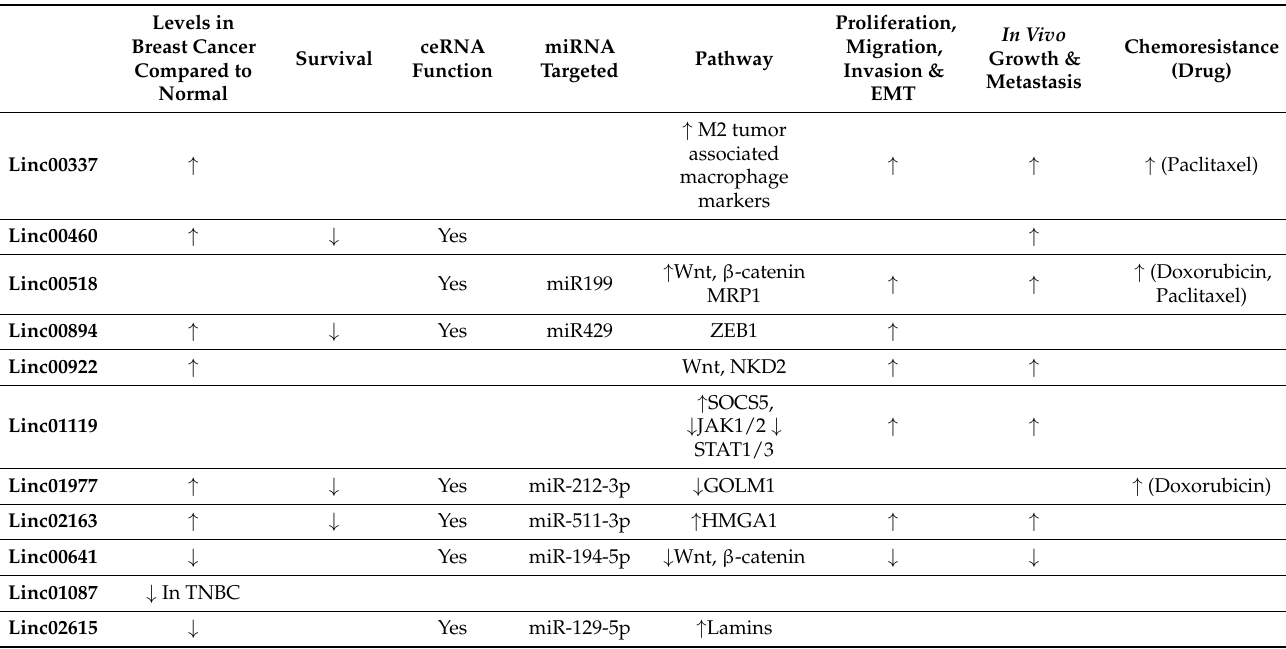
Table 1. Summary of studies correlating the function of different lincRNAs in breast cancer progres- sion and